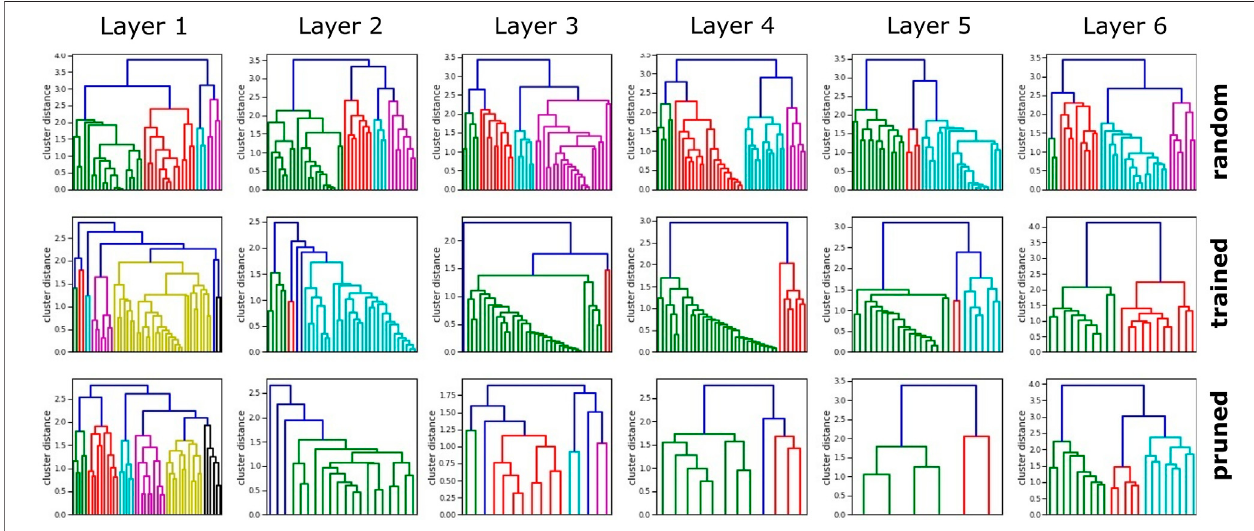
FIGURE 3 | Clustering dendrograms are generated based on the distance measures for an exemplary trained network. Untrained networks show very similar clusters, trained network highlights cluster groups, and pruning reduces neurons while increasing cluster distance. The fi rst layer generally keeps the most distinct clusters, and the penultimate layer shows the strongest neuron